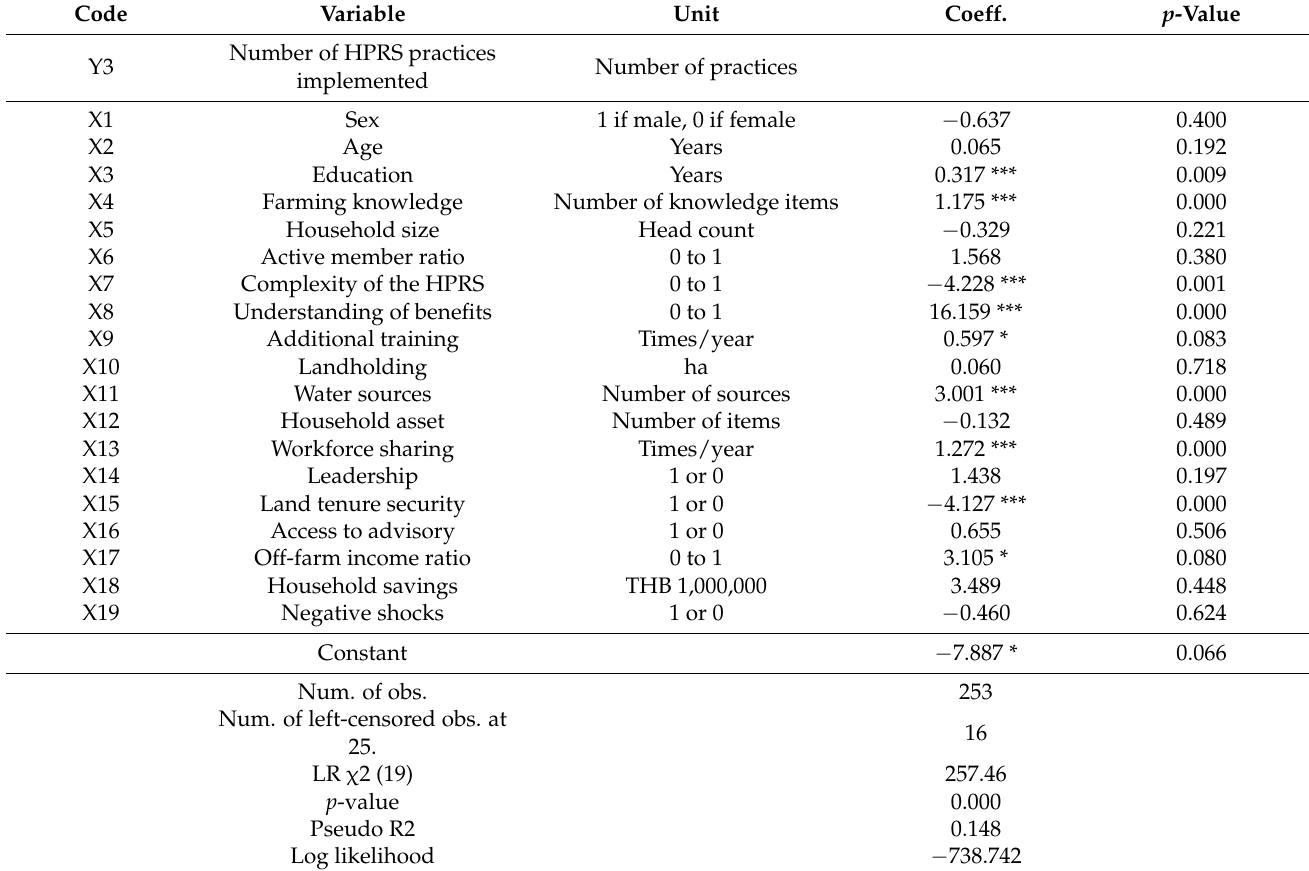
Table 9. The estimated determinants of the number of HPRS practices adopted: the tobit